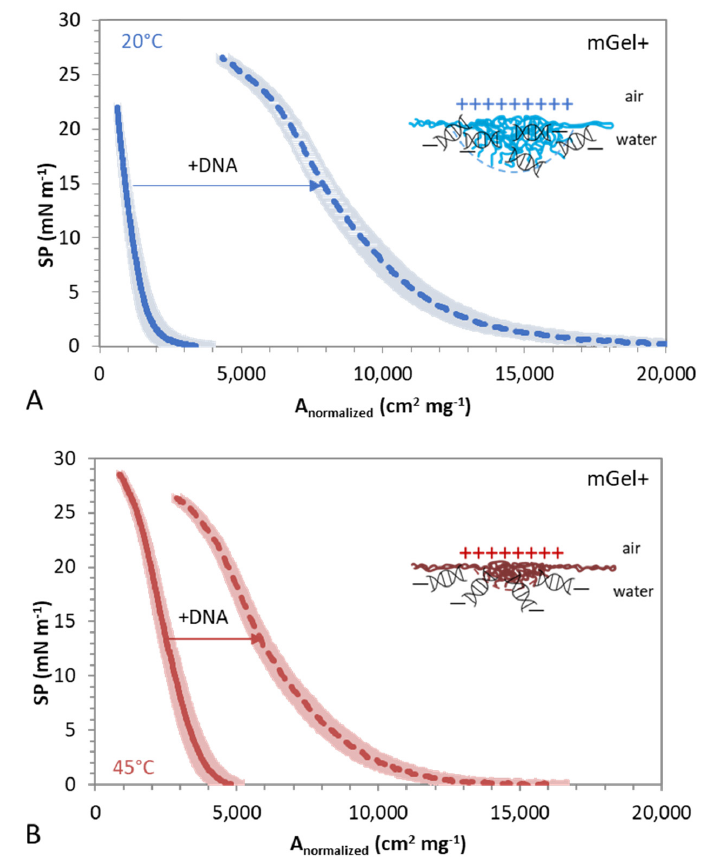
Figure 4. Surface pressure area compression isotherms for mGel+ spread on ultrapure water (solid lines) and on subphase with [DNA] = 0.025 g L − 1 . ( A ) Swollen microgels, 20 °C. ( B ) Shrunken microgels, 45 °C. Values plotted are the mean of three independent measurements with standard deviation in lighter color. Schematic diagram of the surface interaction between DNA/mGel+. DNA illustration is not to scale.